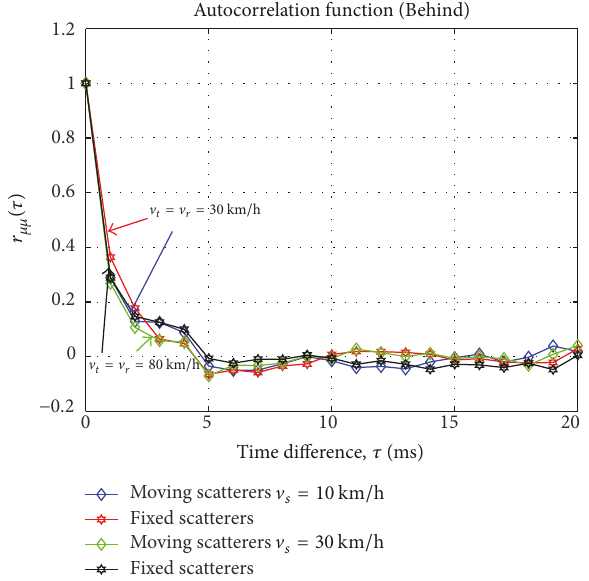
Figure 9: Behavior of ACF 𝑟 𝜇𝜇 (𝜏) presented in Figure 3(a) for V2V scenarios (“Ahead” central angle: 𝜃 𝑡 = 30 ∘ , 𝜃 𝑟 = 60 ∘ uniform distribution).